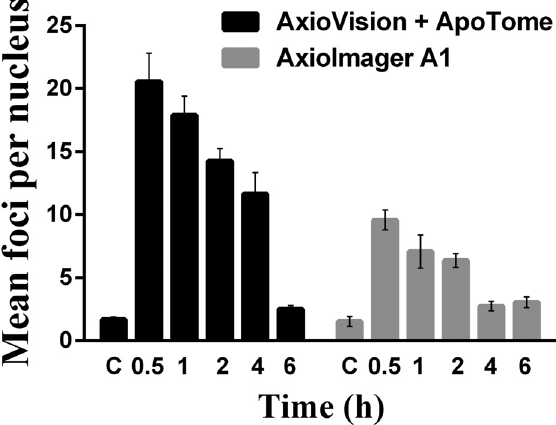
Figure 5 - Kinetics of appearance and disappearance of γ H2AX foci (time dependent mean number of foci) per HTB140 cell nucleus after irradiation with 2 Gy γ -rays (C-control). Quanti fi cation was performed with the microscopes AxioVision comprising ApoTome software and AxioImager A1. Data obtained from 3 experiments are presented as mean ± SEM.